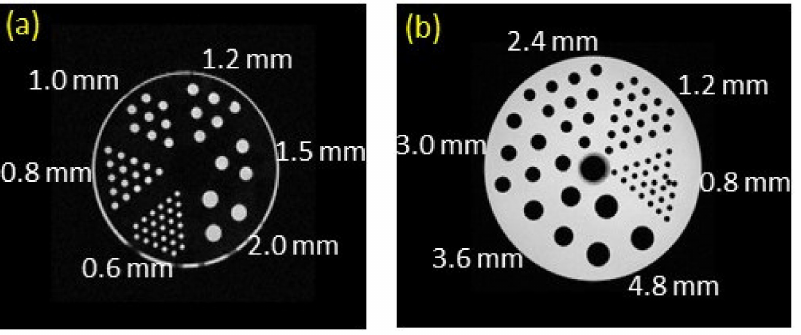
Figure 6. The transverse MRI images of mouse, and rat like Derenzo phantoms ( a ) Mouse-sized hot rod image and ( b ) rat-sized cold rod image.